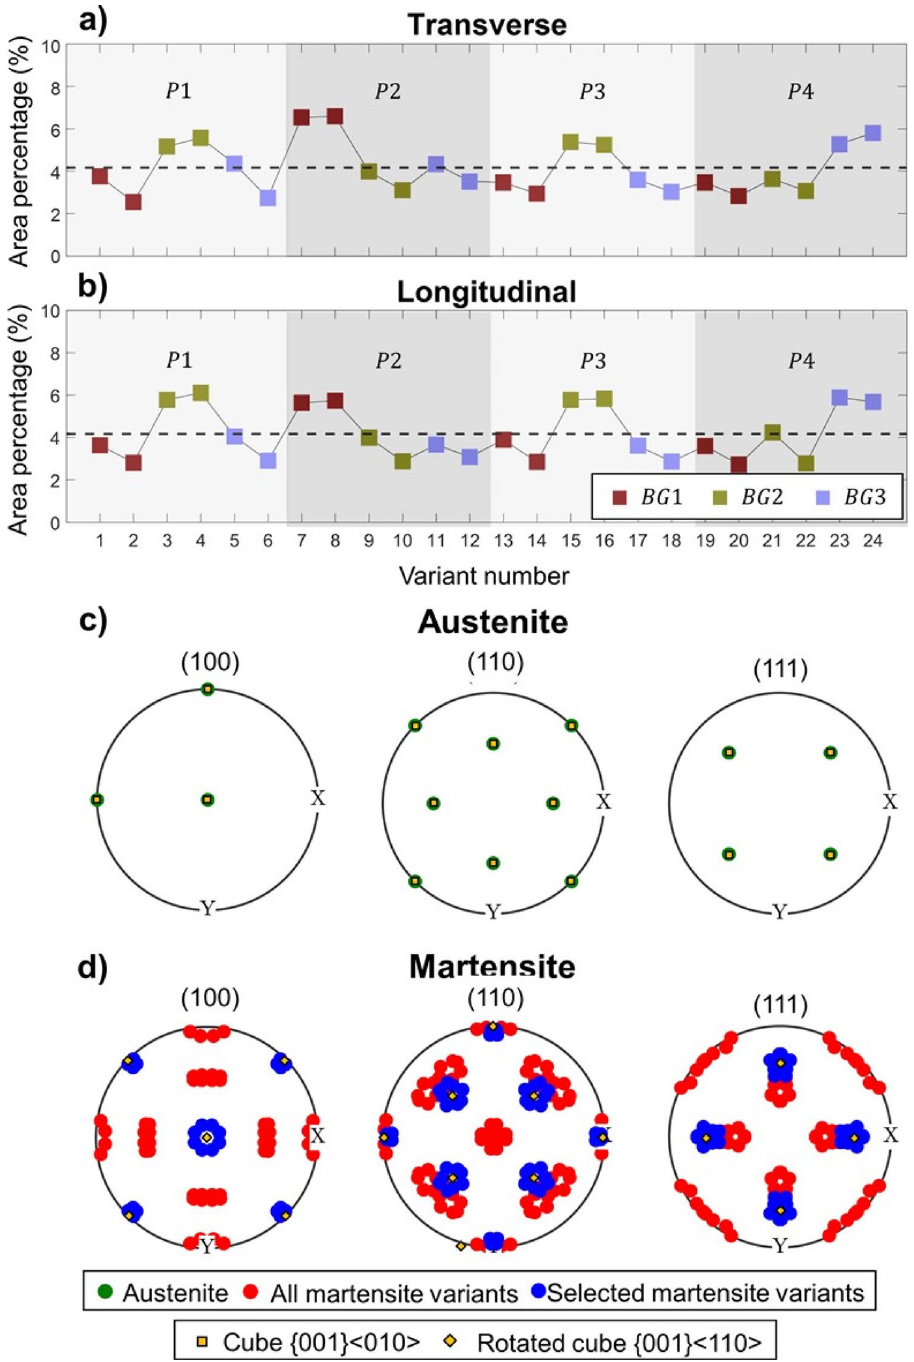
Figure 6. Variant selection study, where ( a , b ) represent the area percentages corresponding to each variant number for the EOS—40 μm—CW laser condition. Data corresponds to the EBSD maps taken on the ( a ) transverse section and ( b ) longitudinal sections. Dashed lines represent the area percentage that would be expected without variant selection. The grey areas show which packets the variants belong to, whereas the marker colors change depending on the BG to which the variant belongs. Subfigures ( c , d ) show the Theoretical pole figures (PF) corresponding to ( c ) the prior austenite and to ( d ) the resultant martensite, calculated by applying the orientation relationship corresponding to all variants (in red) or only the selected variants (in blue). PFs correspond to the